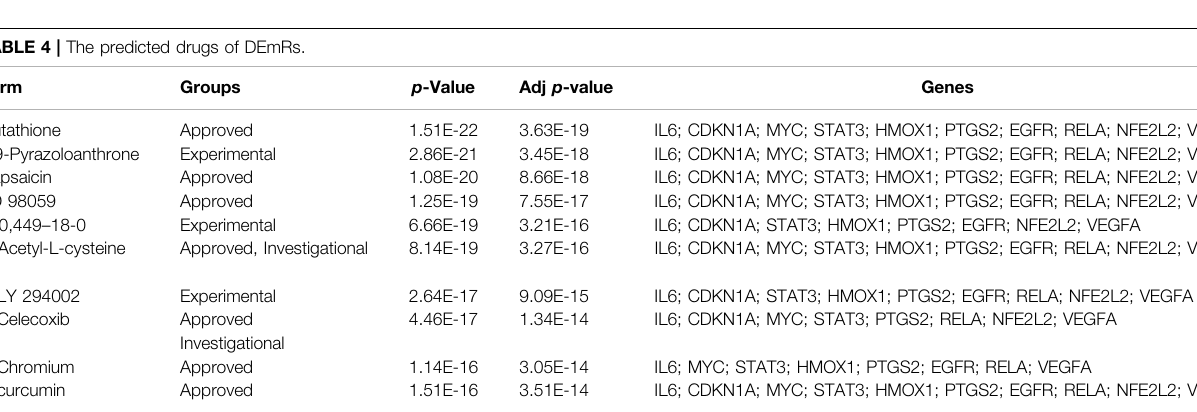
TABLE 4 | The predicted drugs of